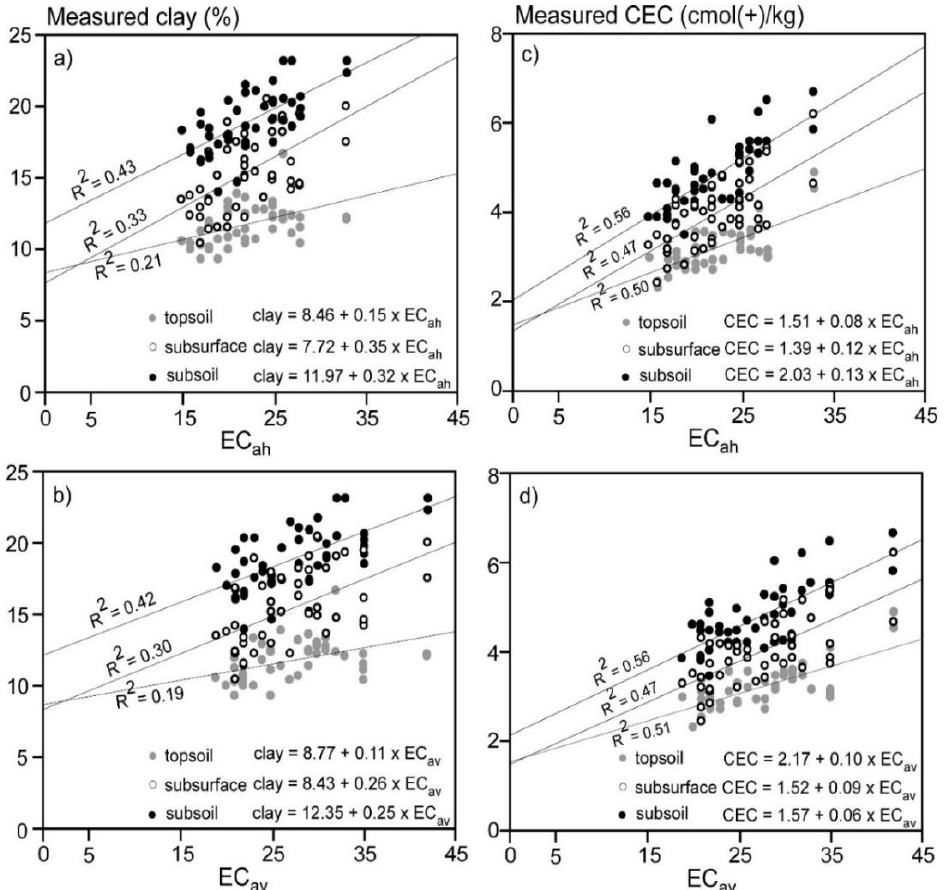
Figure 5. Plots of linear regression (LR) between apparent electrical conductivity (EC a —mS/m) measured in ( a ) horizontal (EC ah ; 0–0.75 m) and ( b ) vertical (EC av ; 0–1.5 m) modes of EM38 and measured clay (%) in the topsoil (0–0.3 m), subsurface (0.3–0.6 m) and subsoil (0.6–0.9) and plots of LR between ( c ) EC ah and ( d ) EC av and measured cation exchange capacity (CEC—cmol(+)/kg) in the topsoil, subsurface and subsoil.